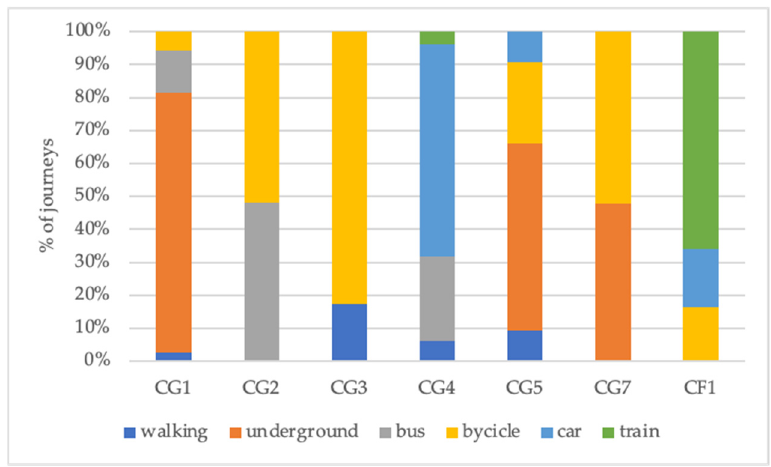
Figure 7. Trips to the site by mode of transport.